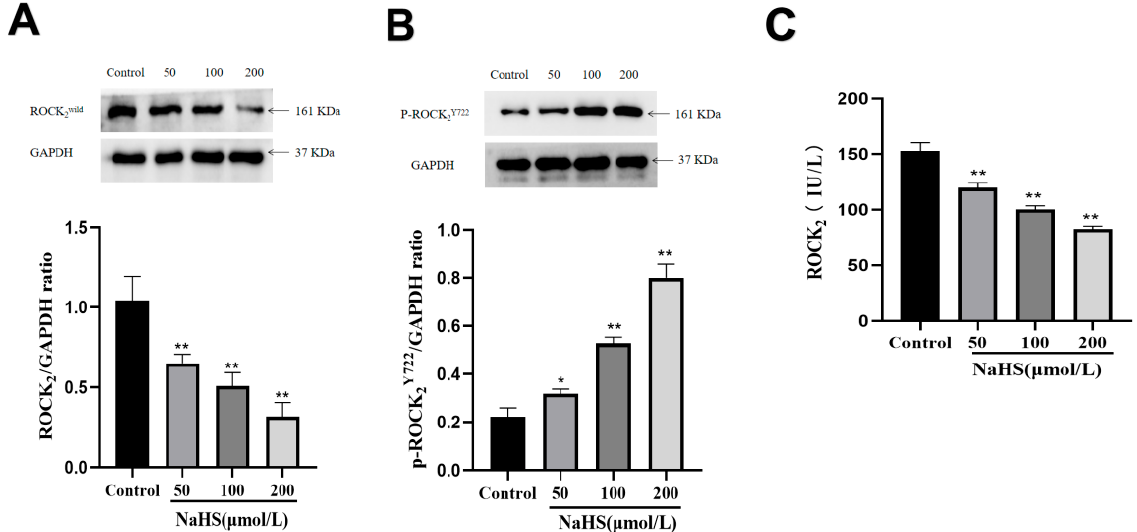
Figure 2. Effects of NaHS on ROCK 2 expression and activity as well as phosphorylation of ROCK 2 at Tyr722 in RHNs. ( A ) ROCK 2 protein expression (Western blot assay, mean ± SEM, n = 3). ( B ) phosphorylation of ROCK 2 at Tyr722 (Western blot assay, mean ± SEM, n = 3). ( C ) ROCK 2 activity (ELISA, mean ± SEM, n = 3). * p < 0.05, ** p < 0.01 vs. control group.